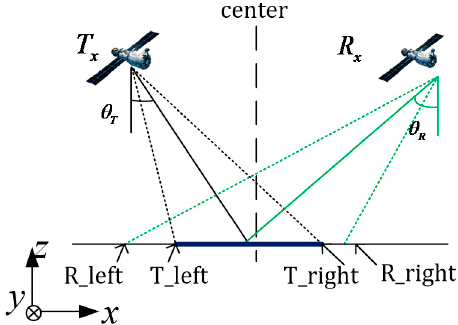
Figure 12. Ghost effect in incidence plane bistatic SAR.